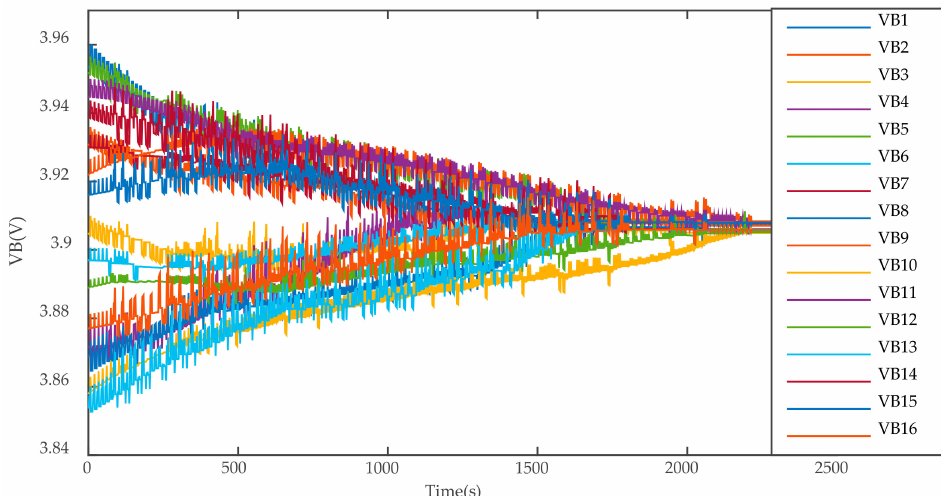
Figure 11. Voltage trajectories of 16 cells in the equalization process.